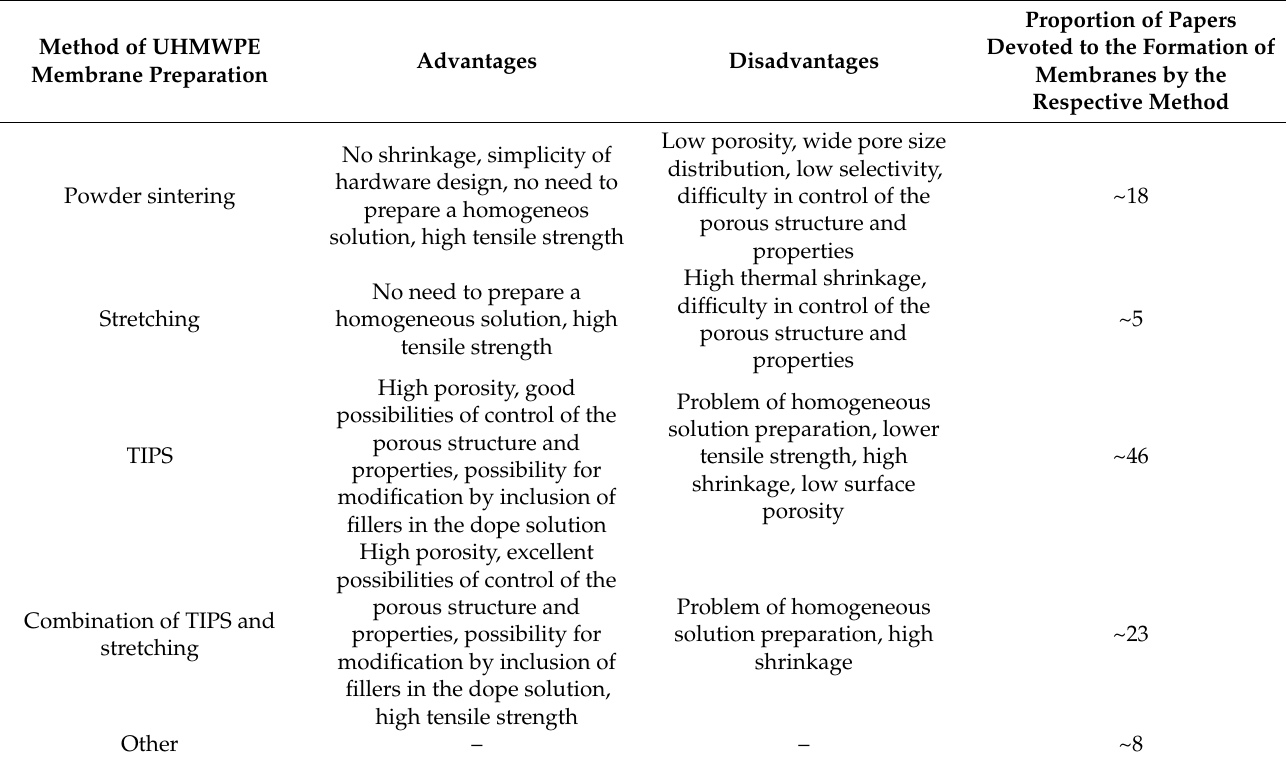
Table 2. Conditions for preparing homogeneous UHMWPE